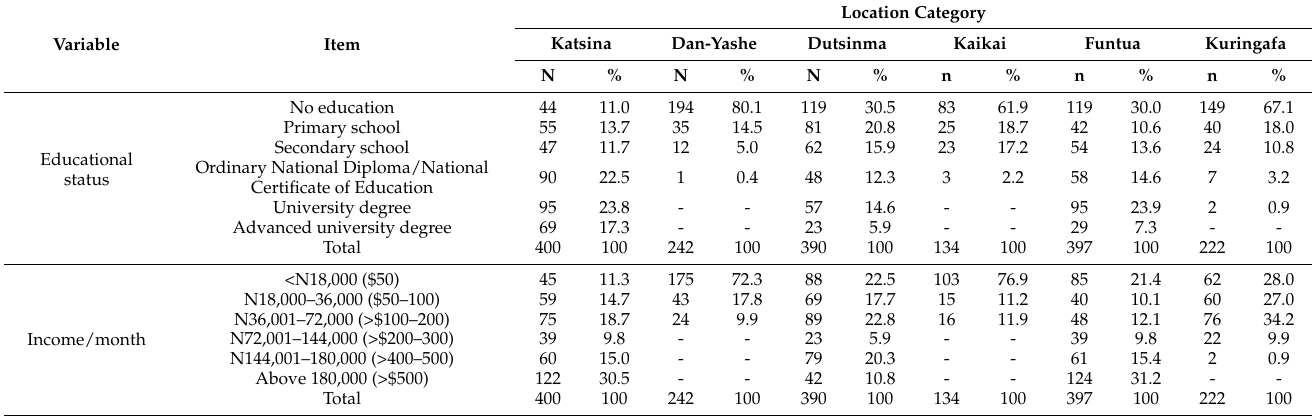
Table 3. Educational level and income of the household heads in the six sampling communities.